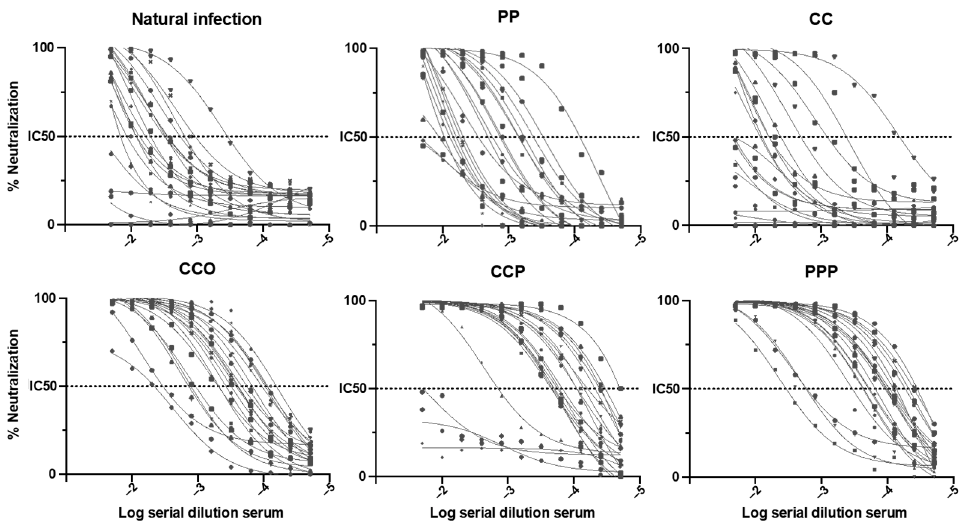
Figure 1. Neutralizing antibodies titration curves for the natural infection group and different vaccination schemes, Chile 2021. CC (CoronaVac CoronaVac), PP (Pfizer Pfizer), CCO (CC plus Oxford AstraZeneca), CCP (CC plus Pfizer), PPP (Triple Pfizer), with n = 20 for each group. The curves were fitted as a dose-response three parameters analysis. Each curve represent a patient, and the dots are the GFP fluorescence value for every serum dilution, using the GraphPad prism 9 software (Graphpad). Table 2. Presence of Neutralizing Antibodies against SARS-CoV-2 among seropositive individuals according to selected variables, Chile November 2021.